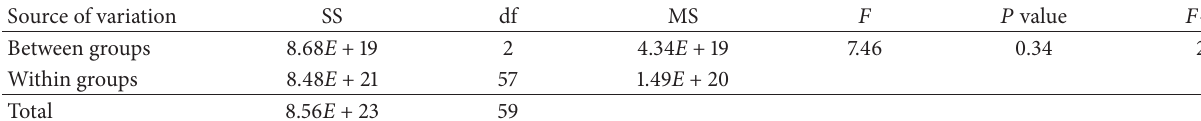
Table 3: One-way ANOVA test results (solution